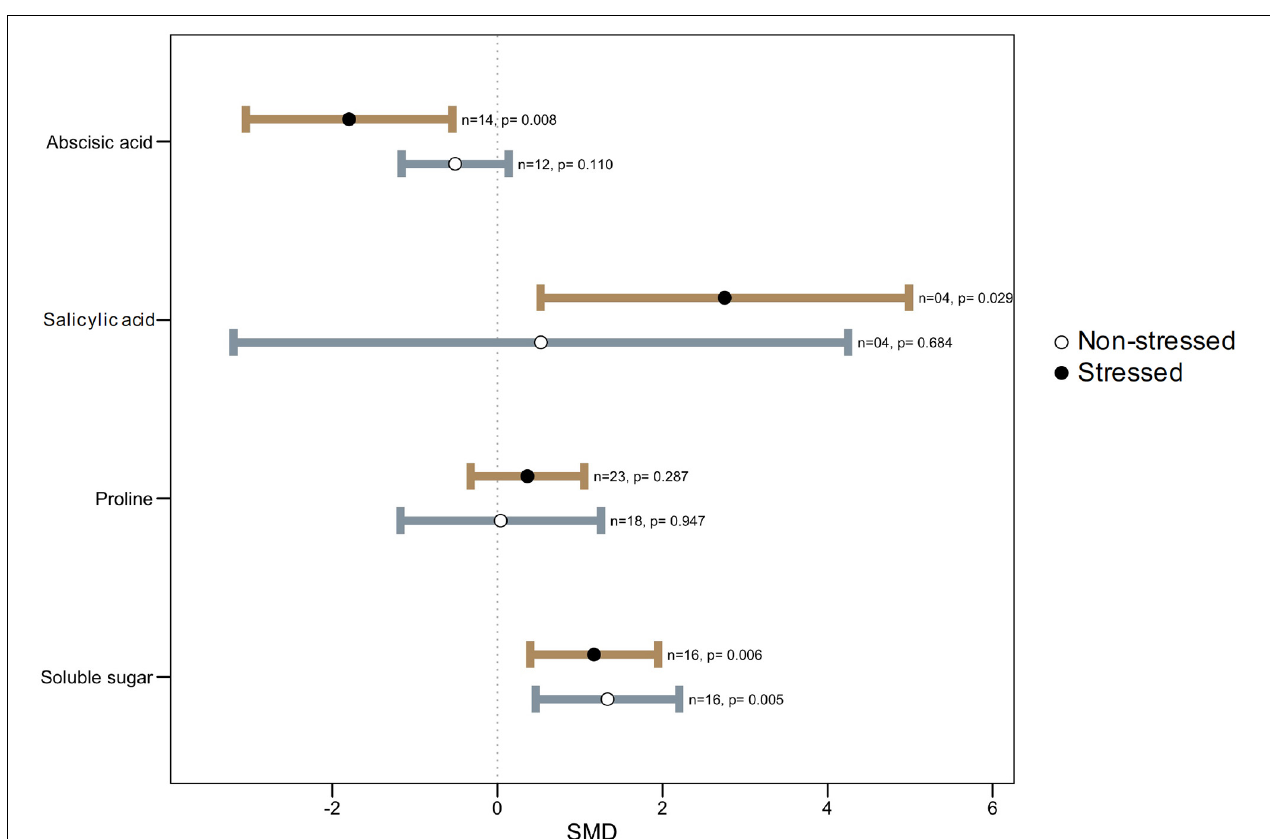
FIGURE 5 | Effect of microbe inoculation on osmplytes and hormones compared with those of non-inoculated plants under heat stress and non-stressed conditions. Error bars are effect size (SMD) means ± 95% CIs. Where the CIs do not overlap the vertical dashed lines, the effect size for a parameter is significant, i.e., the growth responses of inoculated plants were significantly different from those of non-inoculated plants. n = number of studies included in the meta-analysis, p = significance level of